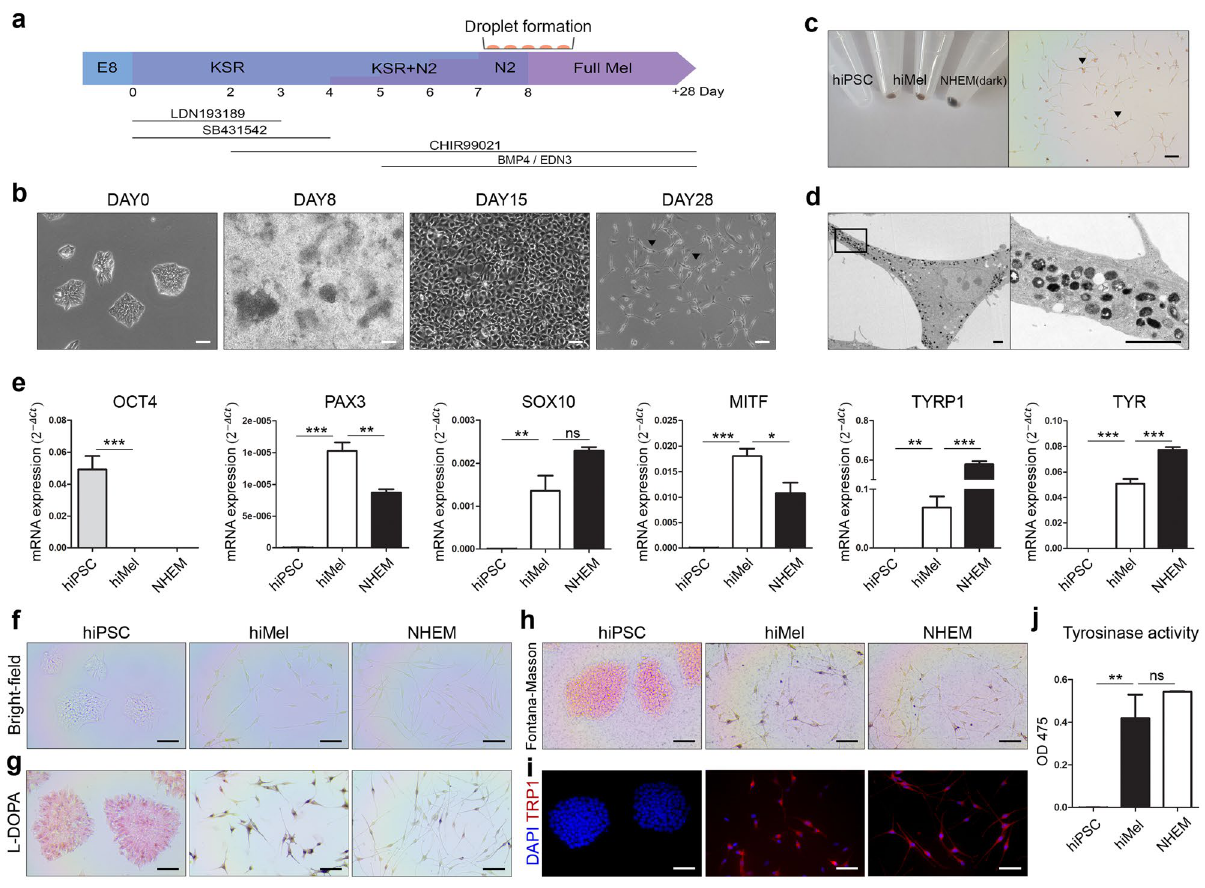
Figure 1. Differentiation of human induced pluripotent stem cell-derived melanocytes. ( a ) Schematic diagram of melanocyte differentiation from hiPSCs. ( b ) Morphology of cells at each stage of differentiation. Scale bar indicates 100 µm. ( c ) Image of day 28 cell pellets showing a darkly pigmented phenotype (left). Pigmented cells visualized under a bright-field microscope (right). Arrowheads indicate pigmented cells. Scale bar indicates 100 µm. ( d ) Transmission electron microscopy (TEM) image of melanosomes in hiMels. Scale bar indicates 2 µm. ( e ) Gene expression of the pluripotency marker OCT4 and melanocyte markers PAX3 , SOX10 , MITF , TYRP1 , and TYR . The relative gene expression values were calculated using the delta cycle-threshold (ΔCt) method. ( f ) Bright-field microscope images of hiPSCs, hiMels, and NHEMs. ( g ) L-DOPA staining of hiMels. Scale bar indicates 100 µm. ( h ) Fontana–Masson staining image of hiMels. ( i ) Immunocytochemical analysis of melanocyte marker TRP1 (red) and DAPI (blue). Scale bar indicates 100 µm. ( j ) Quantification of tyrosinase activity in hiMels. Data are expressed as the mean ± SEM. * p < 0.05, ** p < 0.01, *** p < 0.001 indicate statistical significance. ns non-significant, hiPSCs human induced pluripotent stem cells, hiMels human hiPSCs